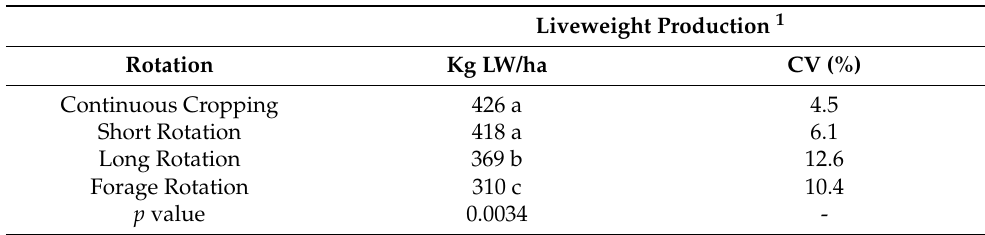
Table 11. Liveweight (LW) production (kg LW/ha) and coefficient of variation (CV, %) in the ‘Palo a Pique’ pasture–crop rotations long-term experiment in Treinta y Tres,